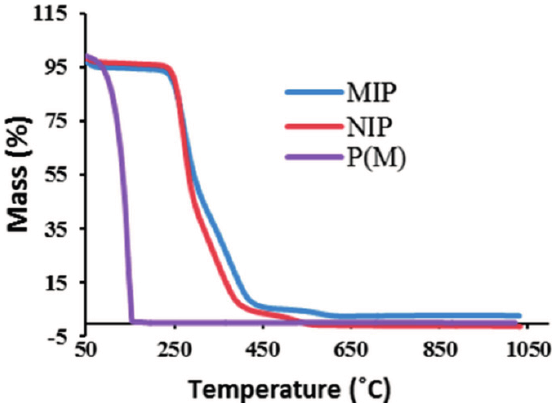
Figure 3. Studies of thermal gravimetric analysis (TGA) for the monomer (P(M)), molecularly-imprinted polymers (MIP), non-imprinted polymer